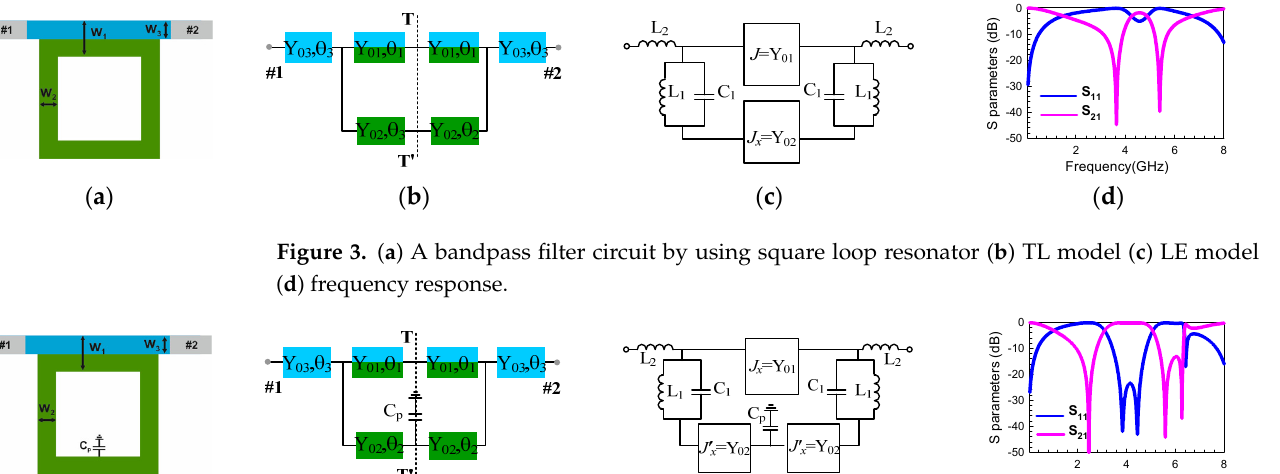
Figure 2. ( a ) A bandpass filter circuit with short-circuited stubs ( b ) TL model ( c ) LE model ( d ) fre- quency response.